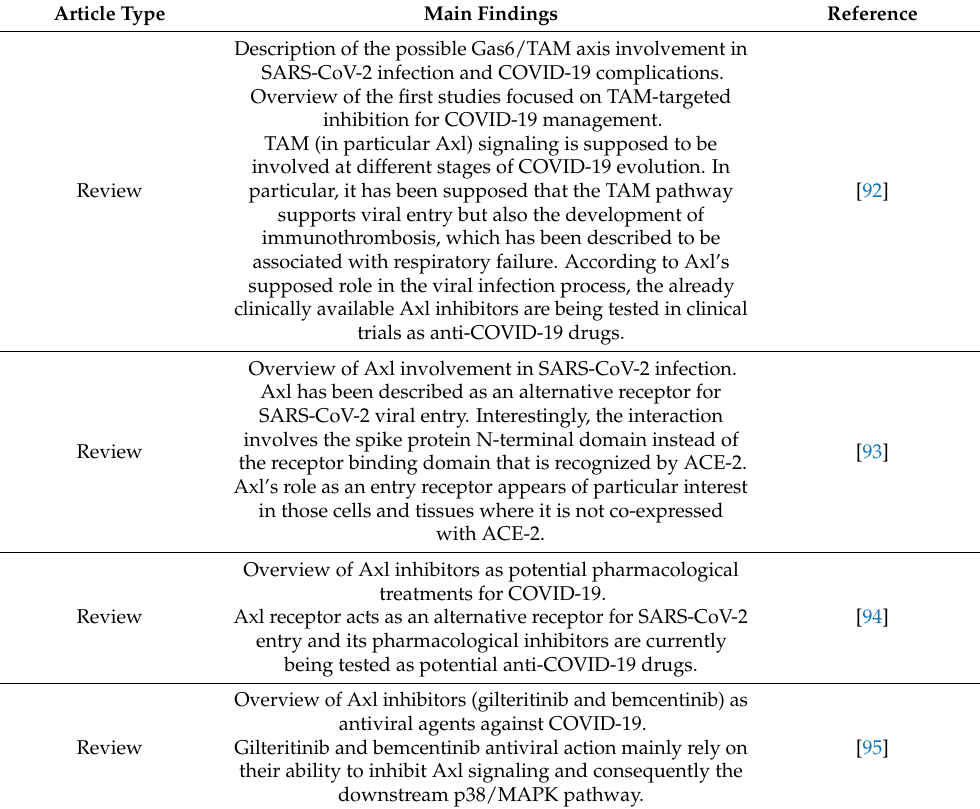
Table 2. Summary of the most relevant reviews regarding the involvement of the Gas6 and TAM receptors in SARS-CoV-2 infection and COVID-19 progression and